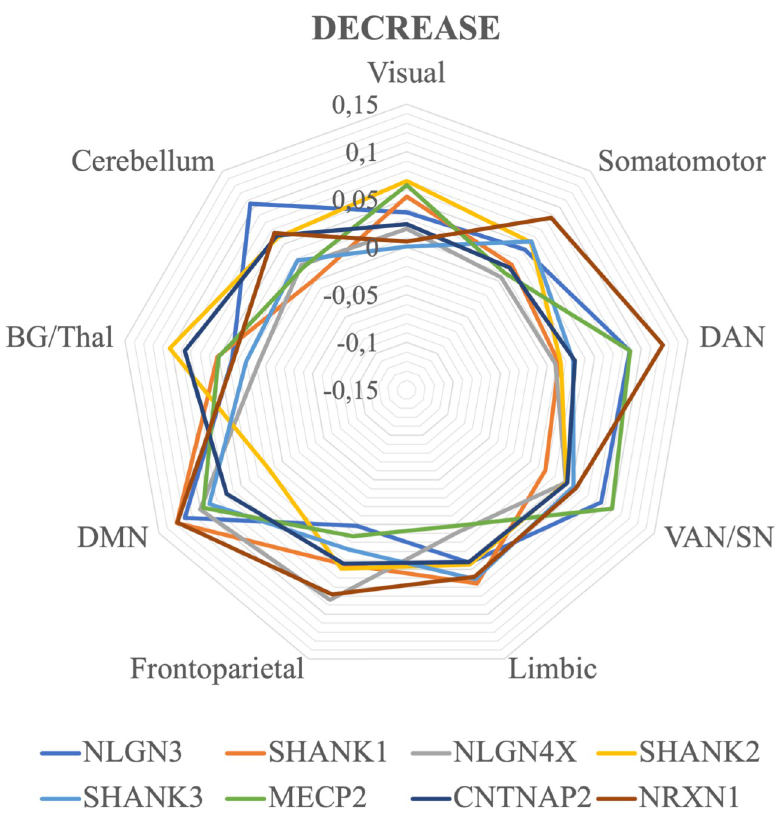
Fig 2. Average correlation between genetic expression and gray matter decreases values for each gene and functional network. The maps are visualized as three-dimensional cortical and cerebellar surfaces. Brain templates are in neurological convention (i.e. R is right, L is left). Color maps represent the correlation values for each gene expression selected. Both significant and non-significant values are represented. SMN: Sensorimotor Network, DAN: Dorsal Attention Network, VAN/SN: Ventral Attention/Salience Network, DMN: Default Mode Network, BG/Thal: Basal Ganglia/Thalamus.